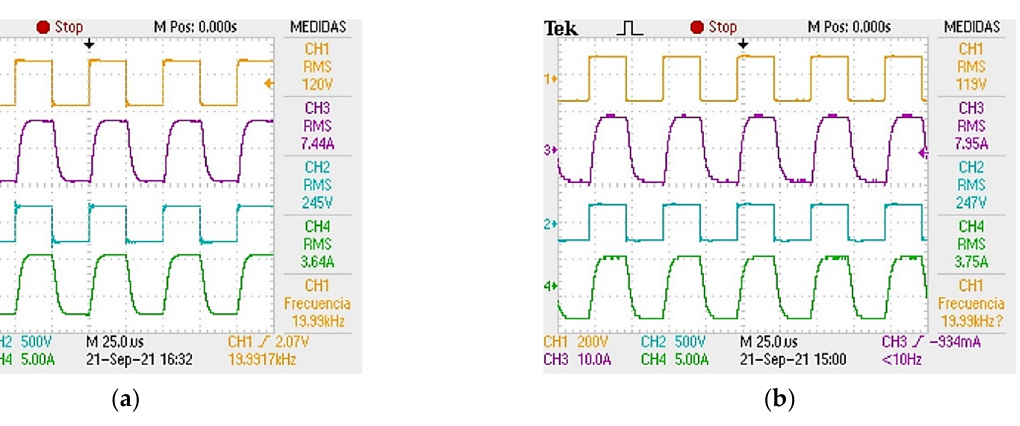
Figure 15. MFT input and output voltages and currents at full load: ( a ) Nanocrystalline, ( b ) Ferrite.